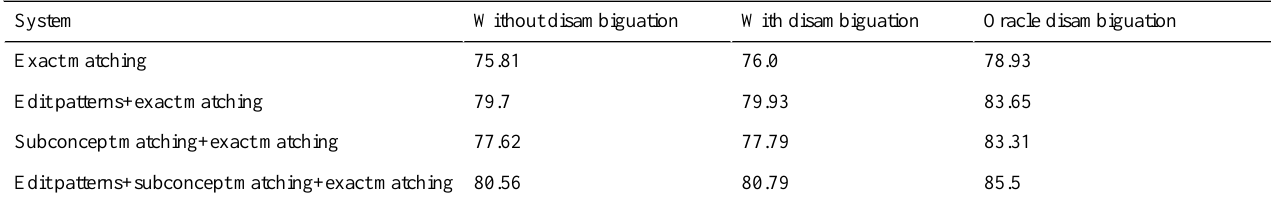
Table 6. Performance evaluation measured in terms of percent accuracy with and without the disambiguation component a